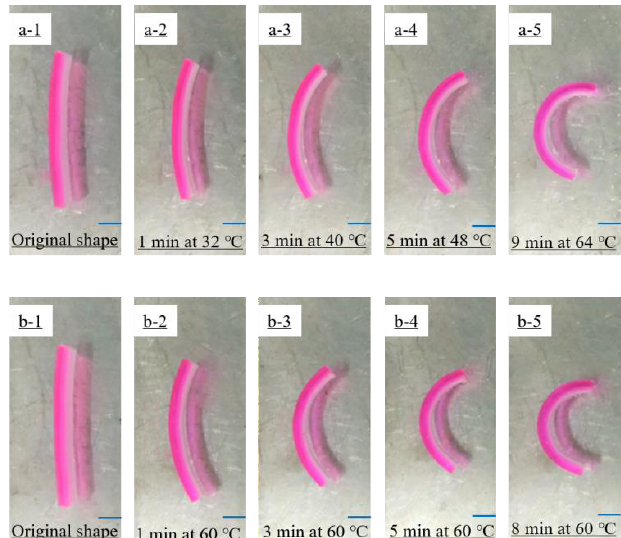
Figure 7. Self-deformation behavior of bilayer hydrogel actuators ( a1 – a5 ) under heating from room temperature (28 ◦ C) at a heating rate of 4 ◦ C/min and ( b1 – b5 ) at a constant temperature of 60 ◦ C. In all images, the AAm/AAc hydrogel layer is on the left and the NIPAM hydrogel layer is on the right.